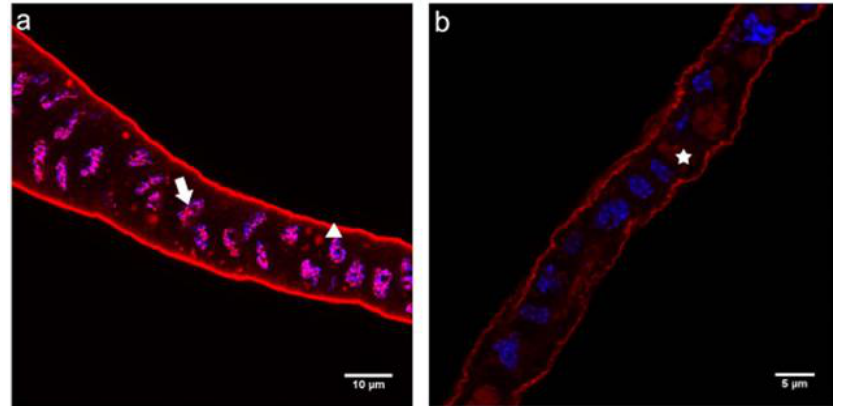
Figure 5. Immunofluorescence analysis with an antibody raised against the N-terminal domain of E-cadherin (E-cadN) performed on ovaries of egg-laying queens ( a , c and e ) and queenless workers ( b , d and f ). Shown are single confocal section images of 1 (cid:541) m thickness. ( a ) E-cadN labeling in terminal filament cells of a queen ovariole appeared scattered throughout the nuclei (arrow) and clustered in certain regions of the cytoplasm (arrowhead). ( b ) In the terminal filament of worker ovarioles, E-cadN labeling was also apparent as cytoplasmic clusters (asterisk), but less so in nuclei. ( c ) In early previtellogenic follicles of queens, strong labeling was seen in the oocyte nucleus (arrow), as well as in the nuclei of trophocytes and follicular epithelium cells (asterisk). Cell-membrane-associated labeling was seen in oocytes (arrowhead). ( d ) In previtellogenic follicles of workers, E-cadN appeared dispersed throughout the cytoplasm of trophocytes and follicular epithelium cells, while cytoplasmic agglomerates were visible in oocytes (arrowhead). ( e ) In vitellogenic follicles of queen ovarioles, E-cadN became localized to the plasma membrane (arrow), but maintained its more homogeneous distribution in the cytoplasm of follicular cells (asterisk). Trophocytes located closer to the oocyte (basal to this image) were intensely labeled in the perinuclear region (arrowhead). ( f ) Trophocytes in the nurse clustered E-cadN labeling in the cytoplasm (arrow). E-cadN immunoreactivity is shown in red, counterstained nuclei are in